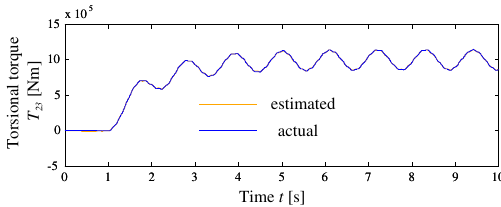
Figure 12. Torsional torque at with white noise.